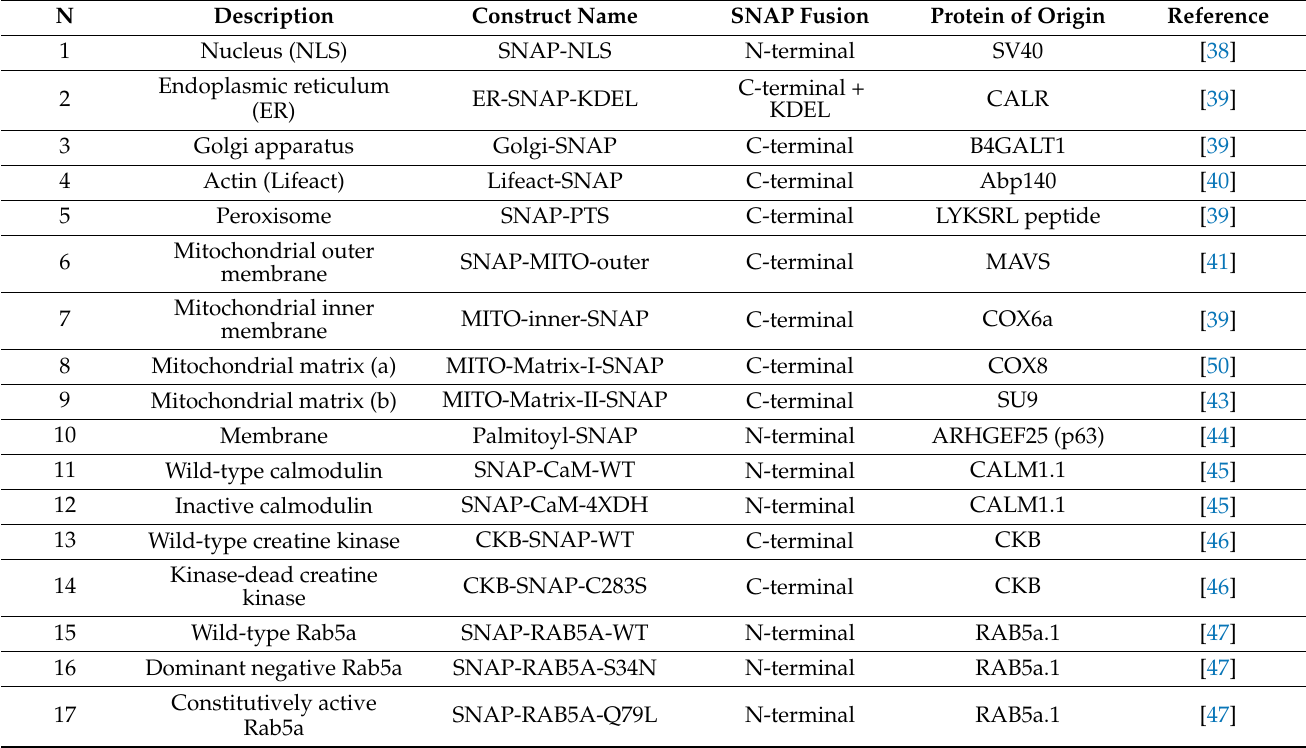
Table 1. SNAP-tag fusion constructs used in this work. For additional sequence details, see Supplementary Table